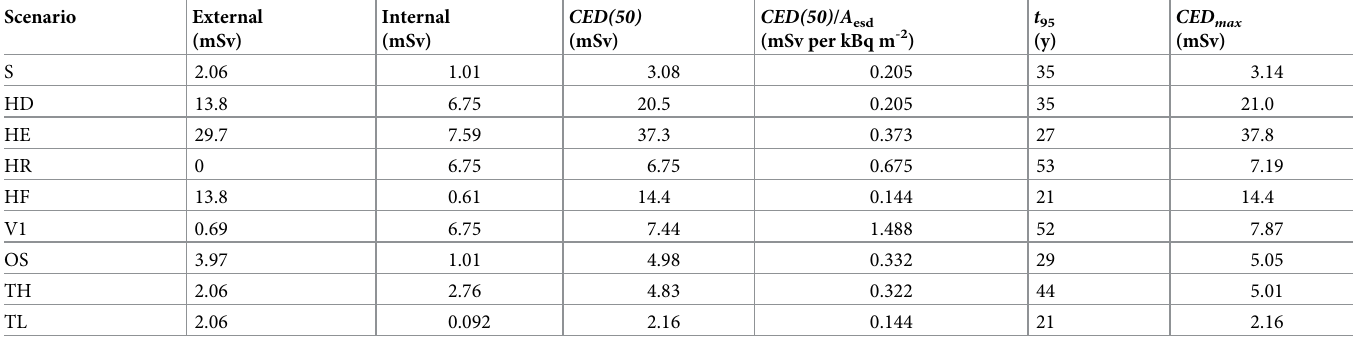
Table 5. Cumulative effective dose (mSv) for adult males, CED(50) , CED(50) per unit deposited activity, time ( t 95 ) at which a plateau is reached (95%), and maxi- mum CED, CED max , assuming the various scenarios described in Table